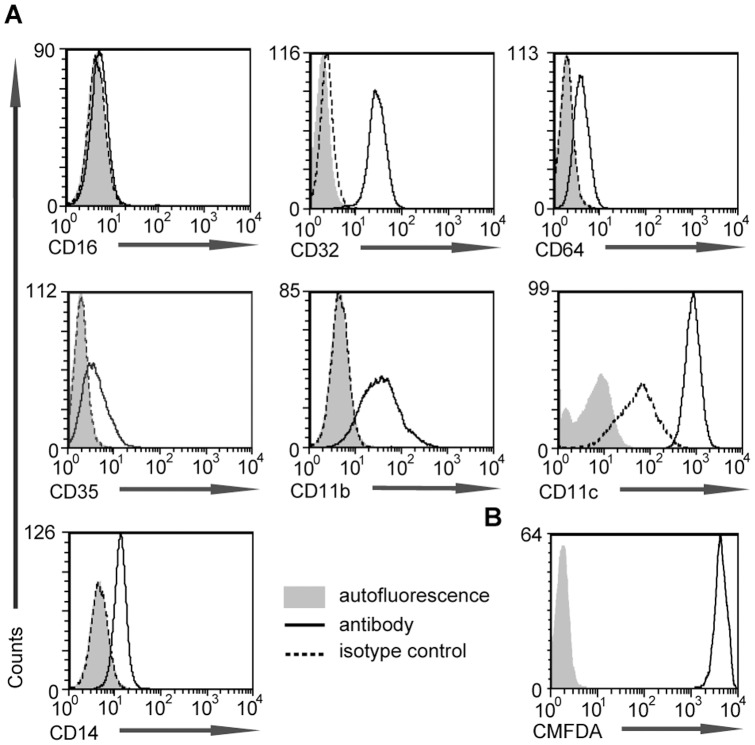
Flow cytometric characterization of U937 cells.Cells were stained (A) with fluorescently labelled antibodies against cell surface Fcγ receptors (CD16, CD32, CD64), complement receptors (CD35, CD11b, CD11c) and LPS coreceptor CD14; (B) with vital dye Celltracker green. Grey histograms indicate autoflourescence, dashed lines show histograms of isotype control antibody stained cells and solid lines stand for signals obtained by receptor specific antibodies or by CMFDA labeling.